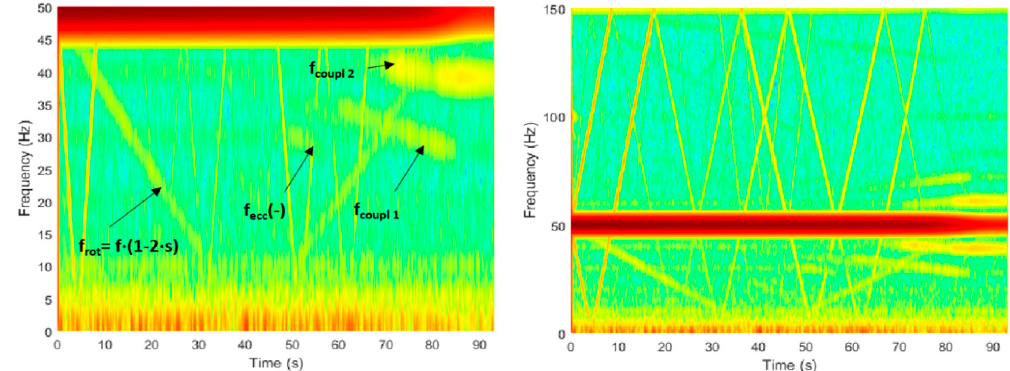
Figure 9. Time-frequency maps of the starting current for a Low Voltage (L.V.) cage motor of the sewage treatment plant.